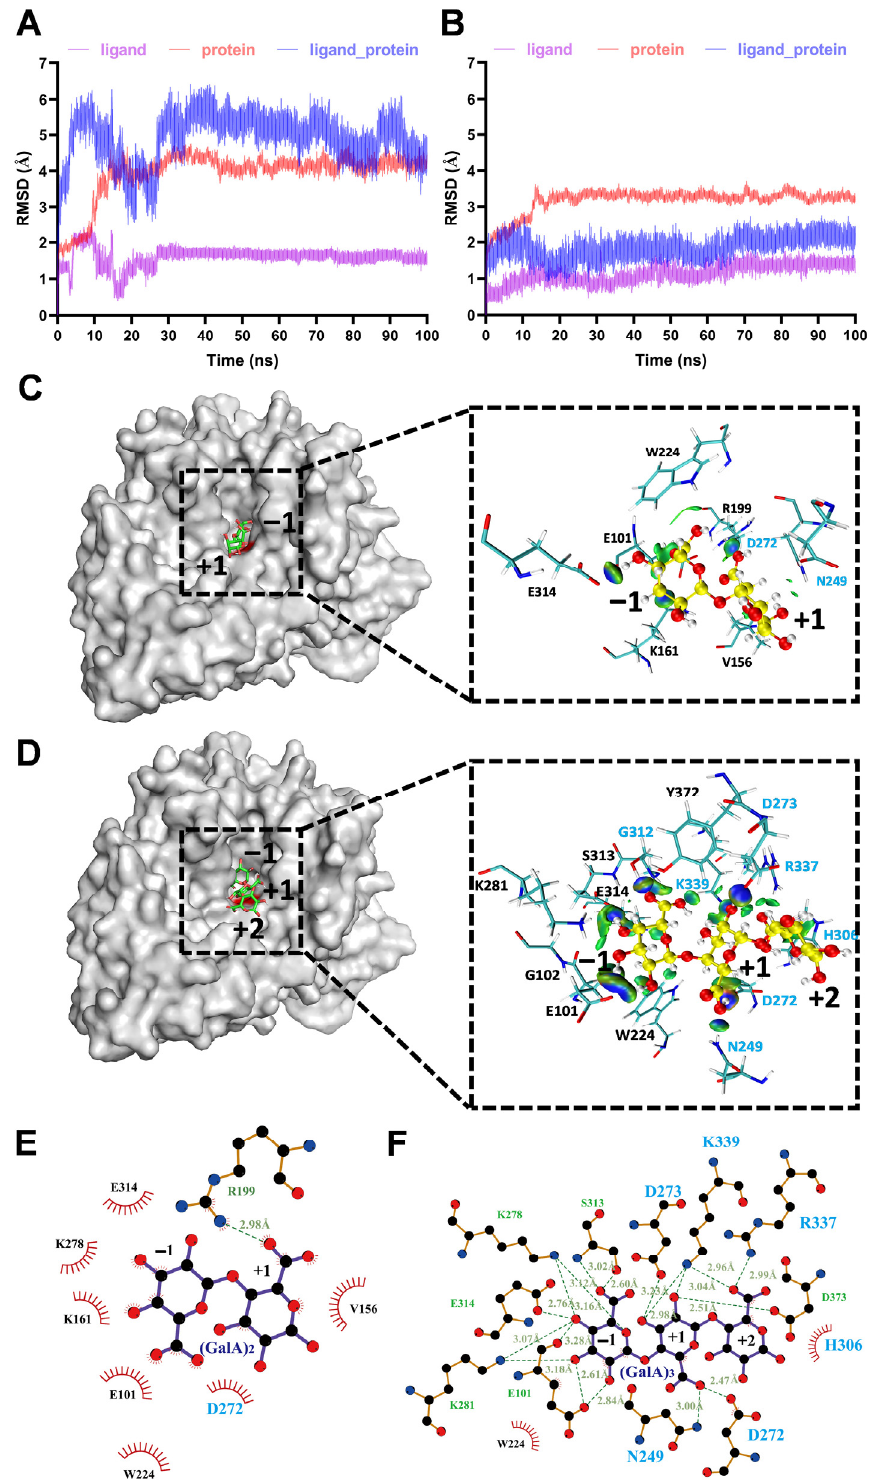
Figure 5. MD simulation of IDSPGA28-16 enzyme–substrate complexes. ( A , B ) RMSD diagram for MD simulation of IDSPGA28-16 and (GalA) 2 ( A ) or (GalA) 3 ( B ); ( C , D ) analysis of MD simulation results of IDSPGA28-16 with (GalA) 2 ( C ) or (GalA) 3 ( D ); representative conformation diagram of the complex clustering for 70–100 ns and the visualized NCI iso-surface diagram between IDSPGA28-16 and (GalA) 2 or (GalA) 3 . Blue indicates hydrogen bonds and green indicates van der Waals interactions; ( E , F ) detailed molecular interactions between IDSPGA28-16 and (GalA) 2 ( E ) or (GalA) 3 ( F ).